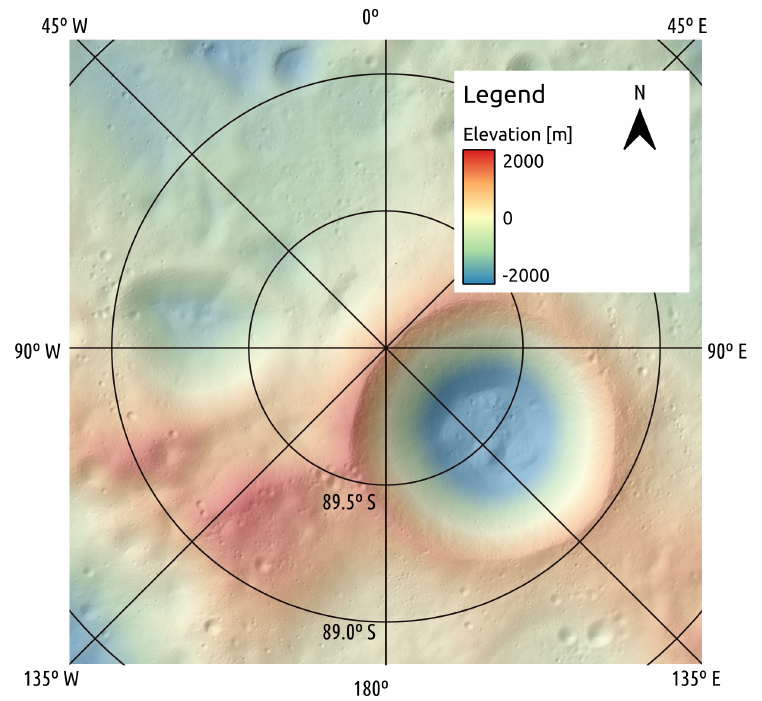
Figure 3. Portion of the digital terrain model covering the RoI. The elevation of the terrain is shown in